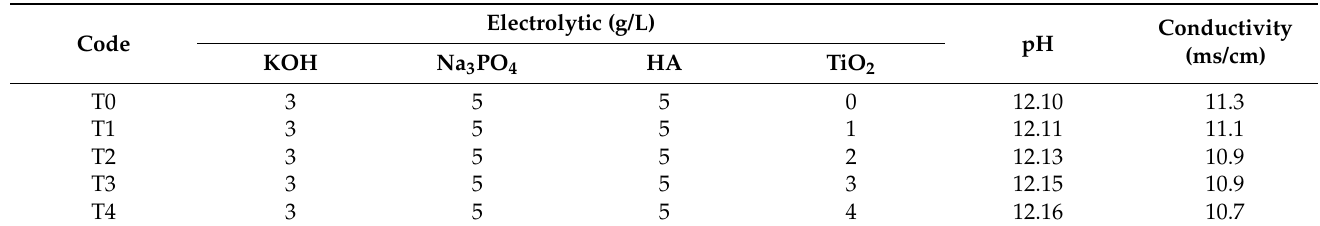
Table 2. Chemical composition of the electrolyte used for the ceramic composite